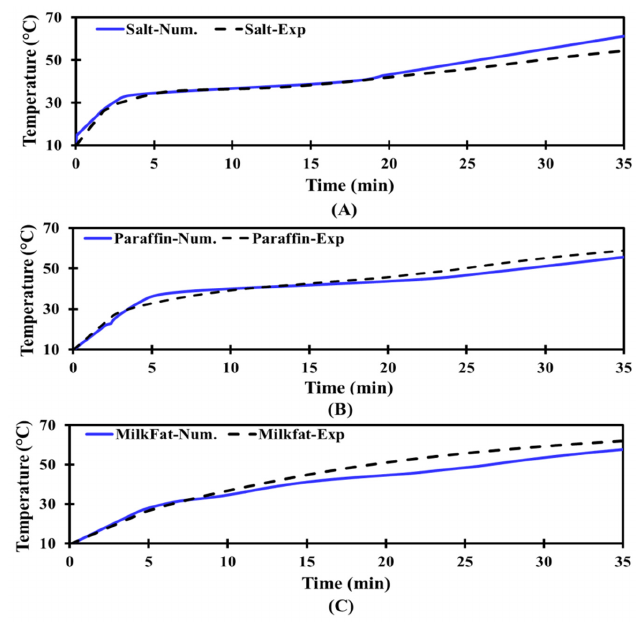
Figure 12. Comparison between simulation and experimental Time-temperature profiles under NV for: ( A ) salt; ( B ) paraffin; and ( C ) milk fat.